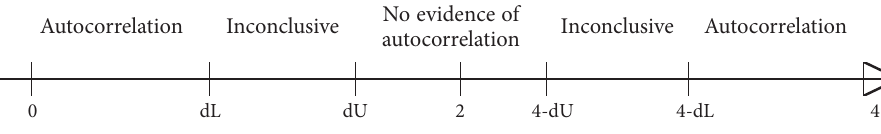
Figure 2. Interpretation of Durbin-Watson statistical values (created by authors according to Brooks,